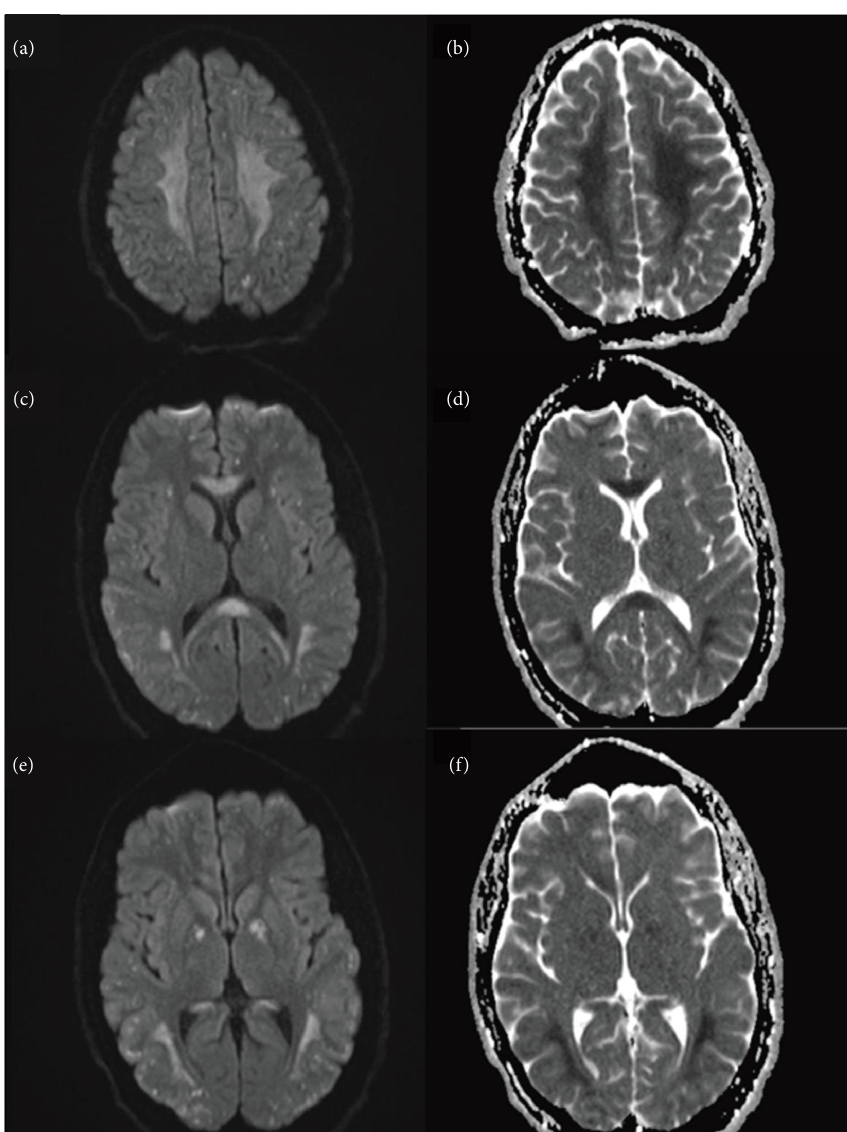
Figure 3: Magnetic resonance imaging (MRI) of the brain showing difusion weighted imaging (DWI; images (a), (c), and (e)) and apparent difusion coefcient (ADC; images (b), (d), and (f)) sequences. Restricted difusion noted in the subcortical white matter (a and b), corpus callosum (c and d), and globus pallidus (e and